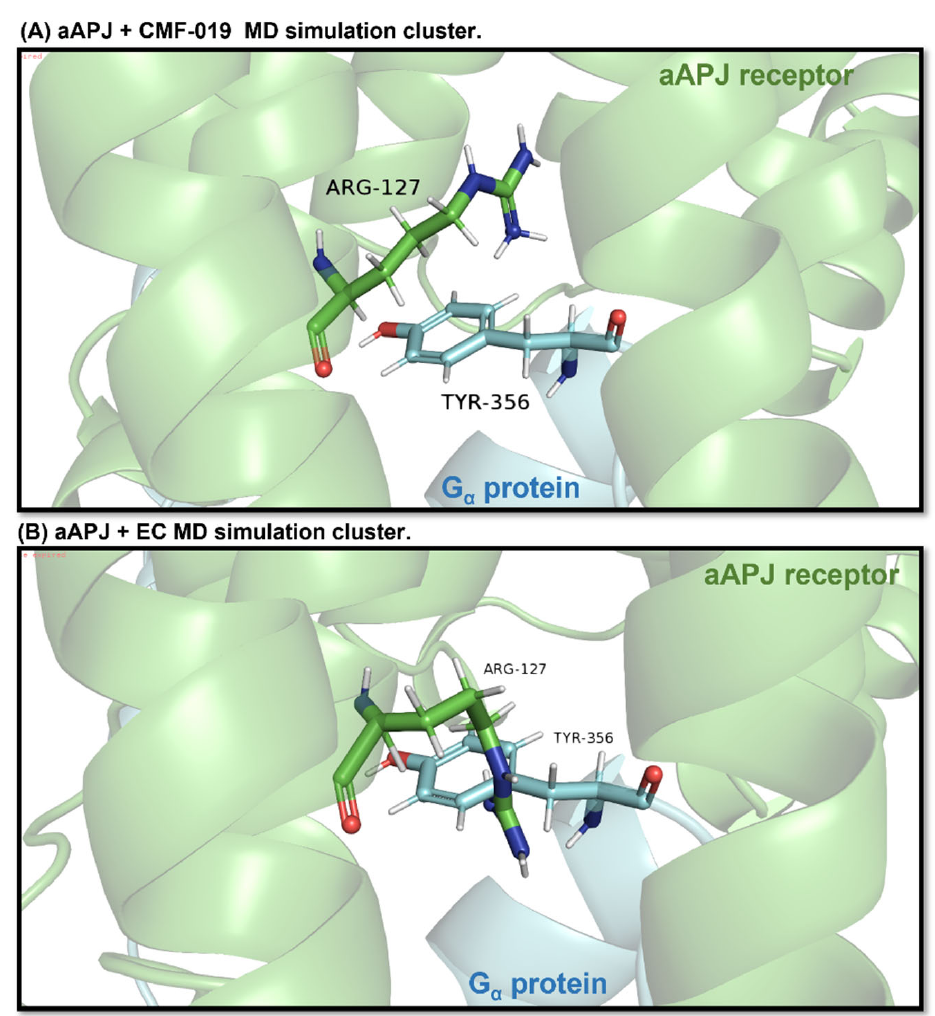
Figure 11. In the images, the aAPLNR and the same receptor residue Arg127 are shown in green. Cyan blue shows the G protein and the same protein residue, Tyr356. ( A ) It can be seen how, in the simulation, the aAPLNR in complex with CMF-019 is at a sufficient distance to allow the G protein to enter the cavity. ( B ) On the other hand, the aAPLNR in complex with the EC is in such a conformation that when placing the G protein, the Tyr356 residue collides spatially with the Arg127 residue of the receptor, which would indicate that the G protein cannot be attached in the closed cavity. Table 6. Summarized data from the MM/GBSA method. vdW: van der Waals; elect: electrostatic; solv: solvent.